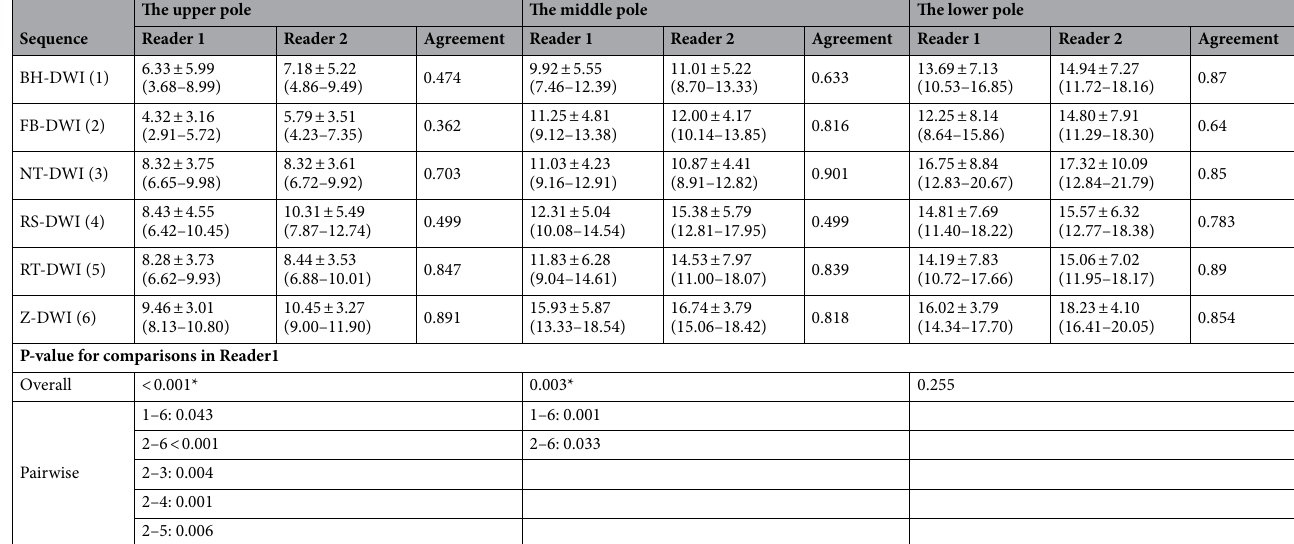
Table 4. Cortico-medullary contrast to noise ratio (c-mCNR) of left kidney. P < 0.05 were considered significant difference (*). P values were presented only when they were less than 0.05. c-mCNR (Cortico- medullary contrast to noise ratio) was measured in different anatomical regions with b = 800 s/mm 2 images. Mean values of c-mCNR with the standard deviation and 95% confidence interval in parentheses are shown. At the bottom, P -values for the overall comparisons using Friedman test are given in reader1. If the Friedman test found a statistically significant P -value, additional P -value was presented with all pairwise comparisons by the Dunn-Bonferroni post-hoc test. BH-DWI breath-hold DWI, FB-DWI free-breathing DWI, NT-DWI navigator-triggered DWI, RS-DWI readout-segmented DWI, RT-DWI respiratory- triggered DWI and Z-DWI Zoomit